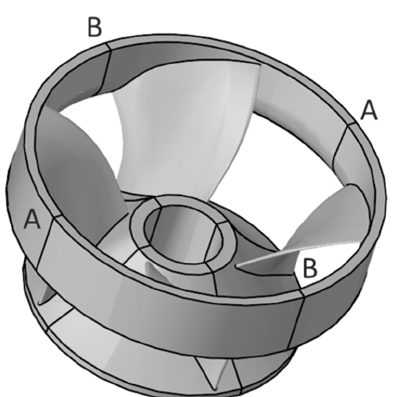
Figure 3. 3D models of runner.